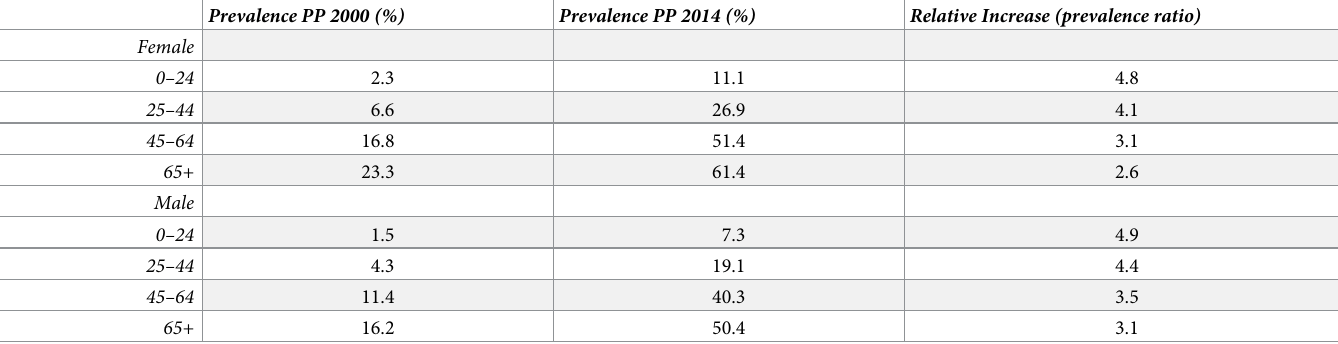
Table 4. Comparison of the prevalence (%) of polypharmacy (PP) at the start and the end of the 15-year trajectory in the fixed cohort in absolute terms and relatively. Prevalence PP 2000 (%) Prevalence PP 2014